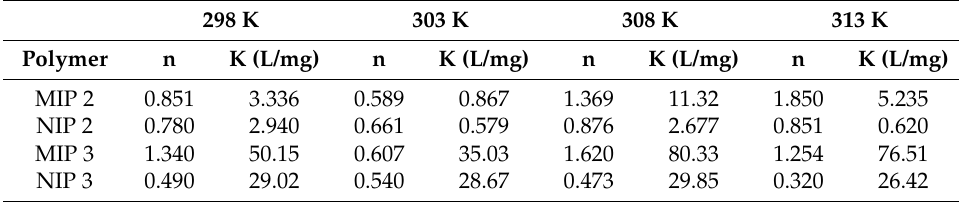
Table 3. Parameters of the Freundlich linearisation isotherms for the retention of BPA with MIPs and NIPs. 298 K 303 K 308 K 313 K Polymer n K (L/mg) n